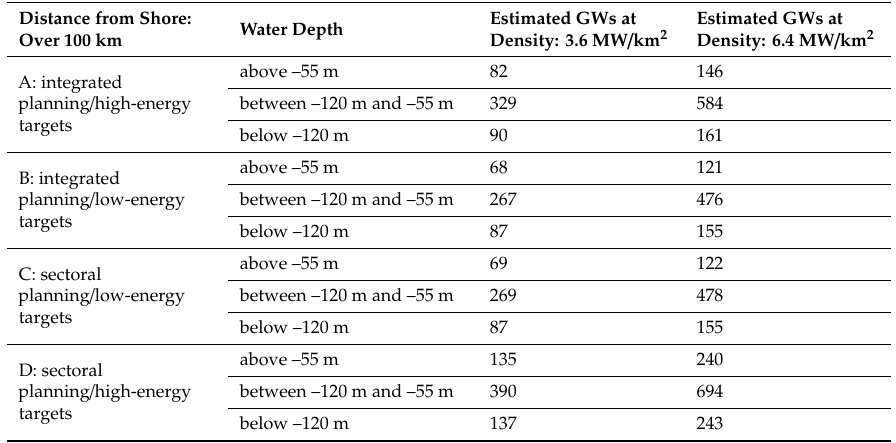
Table 14. Available space (km 2 and estimated GWs) for single use: over 100 km from shore, with a water depth above –120 m (without considering multi-use in Scenarios A and